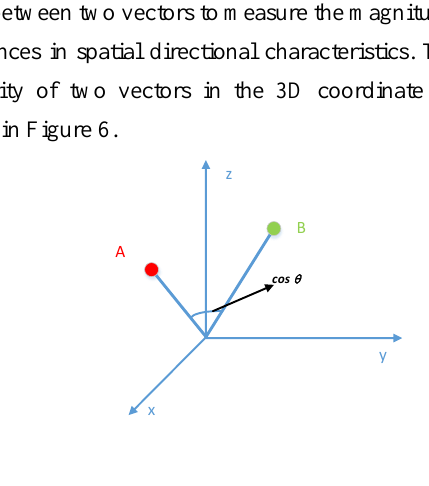
Figure 6. Cosine similarity between vectors in three- dimensional coordinate